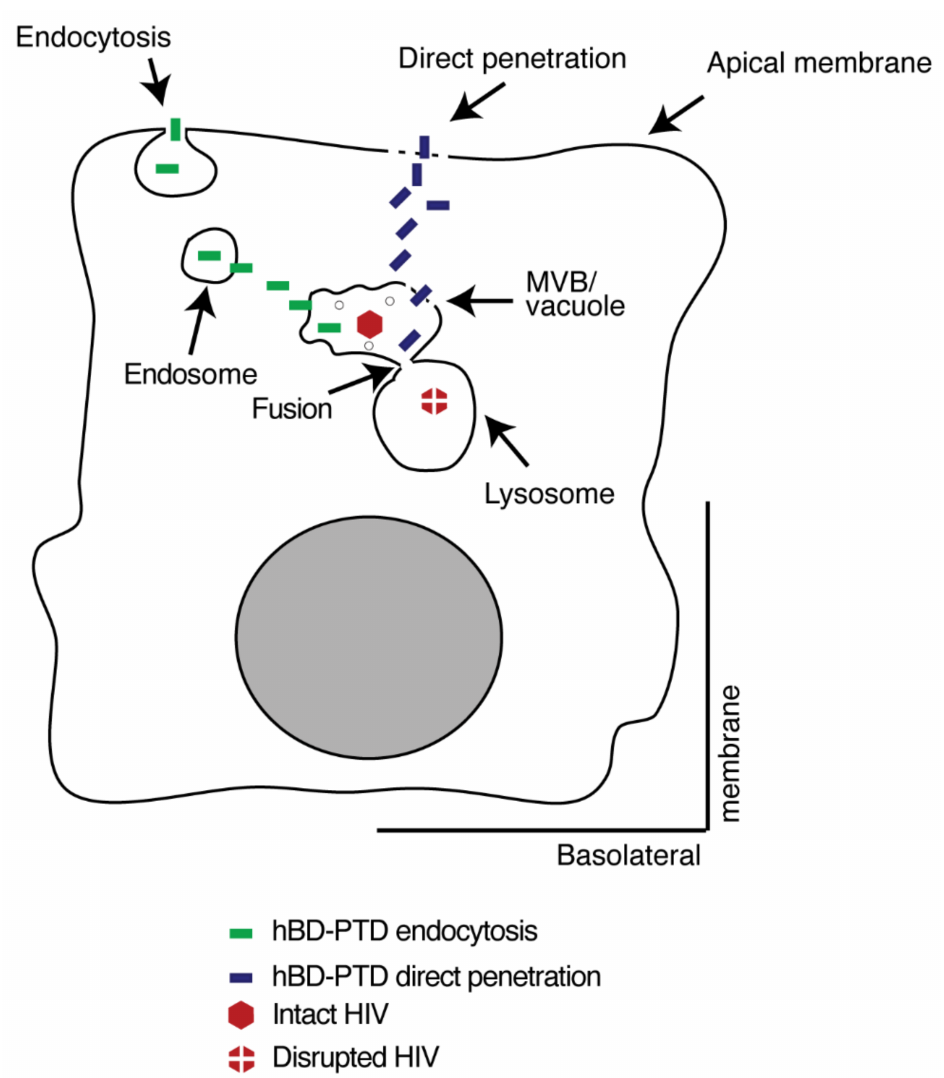
Figure 12. Model of hBD-2 PTD - and hBD-3 PTD -mediated inactivation of HIV-1 in tonsil epithelial cells. HIV-1 is internalized into polarized tonsil epithelial cells, and the majority of virions are sequestered in the MVB and vacuoles. hBD-2 PTD and hBD-3 PTD internalize into tonsil epithelial cells through endocytosis and direct penetration. hBD-2 PTD and hBD-3 PTD endocytosis generates endosomes containing hBDs, which are released from endosomes into cytosol and subsequently enter other endosomes, including those containing HIV-1, by direct penetration. hBD-2 PTD and hBD-3 PTD that directly penetrate via plasma membrane will also subsequently penetrate various vesicles, including MVB and vacuoles containing HIV-1. Vesicles containing HIV/hBD-2 PTD /hBD-3 PTD may fuse